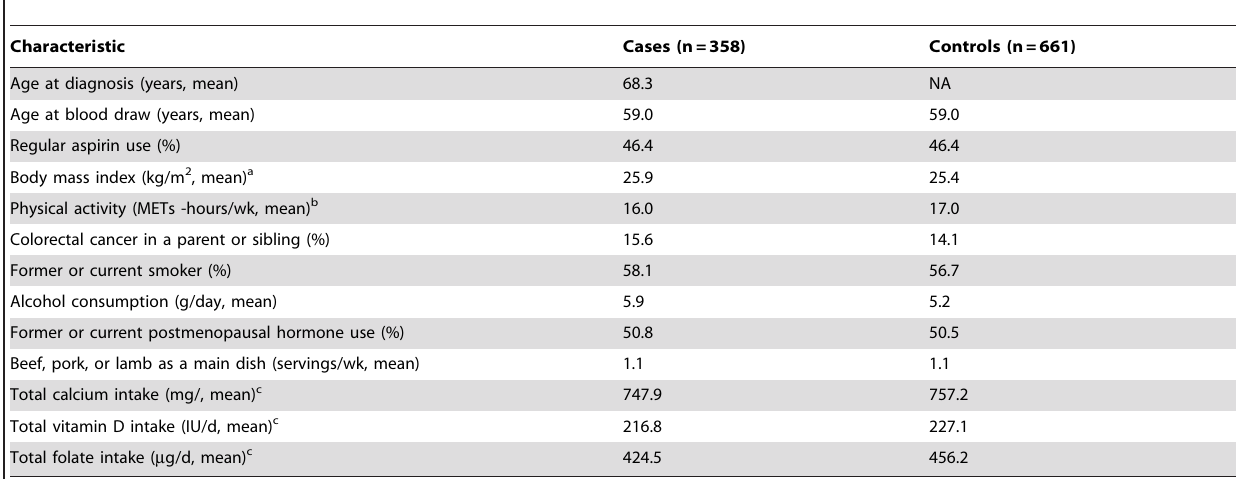
Table 1. Characteristics of colorectal cancer cases and controls in the nested case-control study within the Nurses’ Health Study.